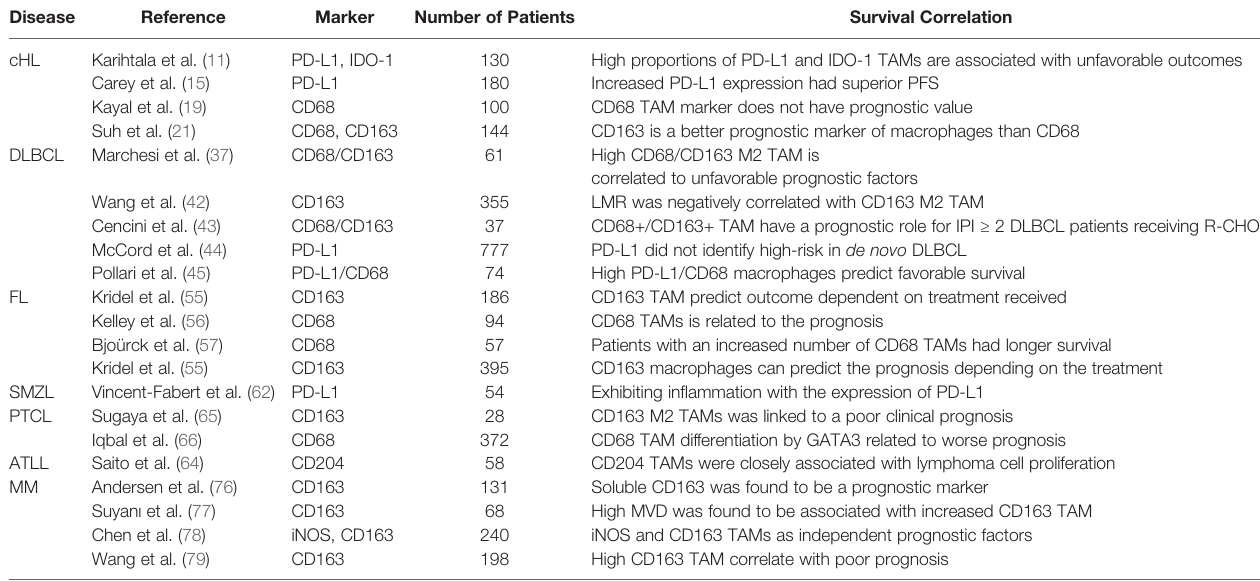
TABLE 2 | The role and prognostic markers of TAMs in hematological malignancies.